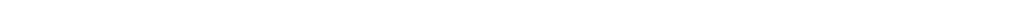
(see fi gure on previous page) Fig. 1 PE induced ef fi cient and precise gene editing in rabbit. a The base insertion ef fi ciency of PE system in HEK293FT cells. b PE induced ef fi cient and precise gene editing in rabbit embryos. c Editing frequency ( HEXA ins TATC) of PegRNA screening with PBS length (8 – 16 nt) in rabbit embryos. d Editing frequency ( HEXA ins TATC) of PegRNA screening with RT template length (10 – 18 nt) in rabbit embryos. e Editing frequency ( HEXA ins TATC) of CRISPR – Cas9 system-mediated HDR compare with PE3. f The target sequence at HEXA locus by PE system. The PAM and sgRNA target sequences are shown in green and black, target mutation (red), frameshift mutation leads to PTC mutation (red and red star). g Editing frequency determination of HEXA ins TATC rabbit by deep sequencing. h Expression of HEXA gene was determined by qRT-PCR. i HEXA protein was determined by western blot. j X-ray radiography of WT and HEXA ins TATC rabbits. Red circle, increased cervical lordosis; Red arrows, clasping of the limbs. k Masson ’ s trichrome staining of gastrocnemius from WT and HEXA ins TATC rabbits. Blue arrow highlights the myopathy with fi brosis and in fl ammatory cell in fi ltration. l HE staining of hippocampus from WT and HEXA heterozygous rabbits. The red arrow highlights the enlargement of perineural